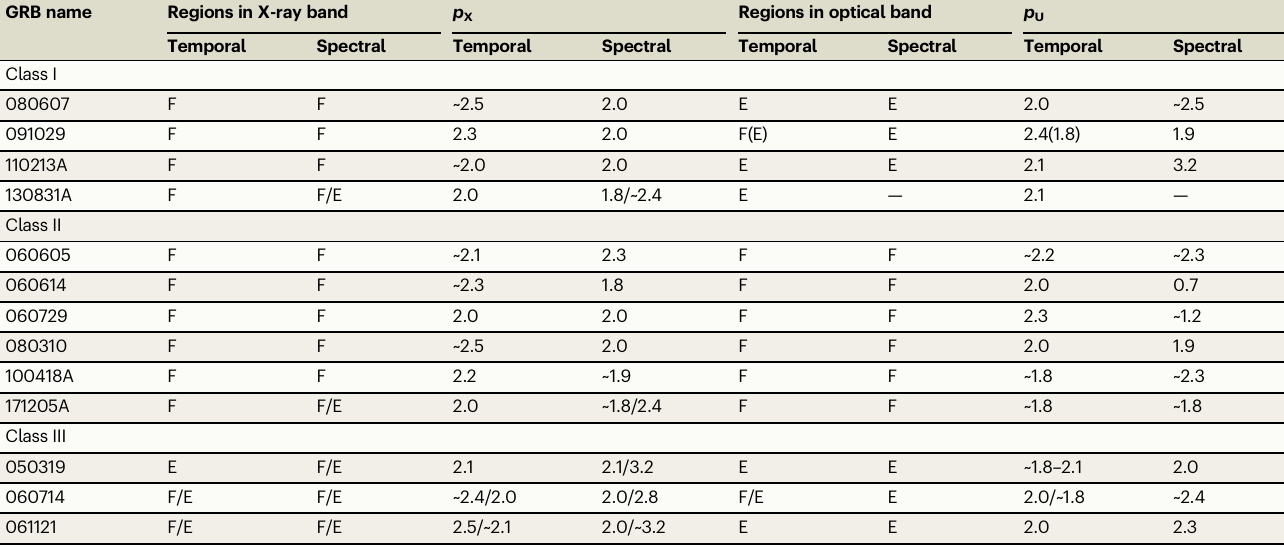
Table 1 | Region and electron power-law index ( p ) in both X-ray and optical bands using both temporal and spectral